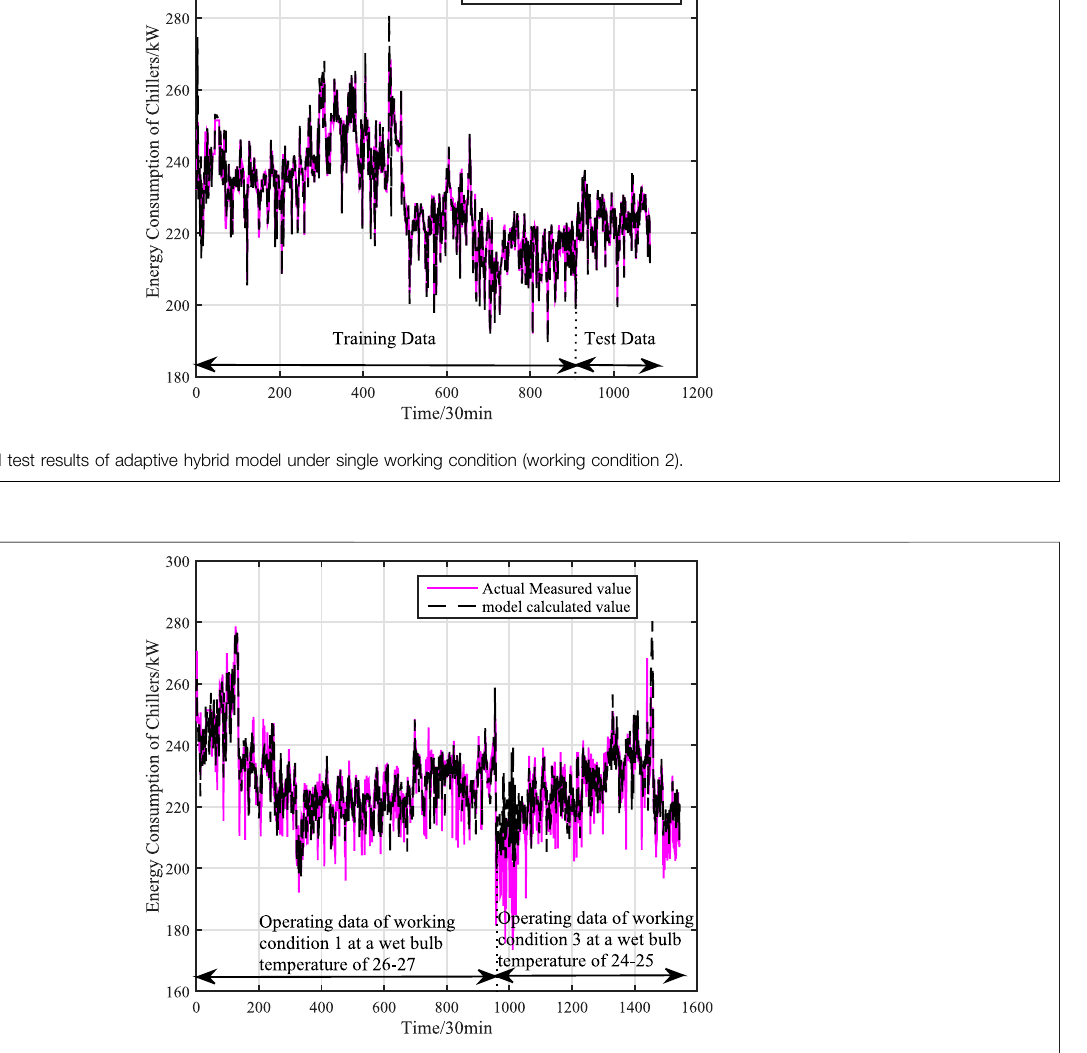
Figure 8 .calculation accuracy of different models under signal working condition (working condition 2) is shown in Table 3 .